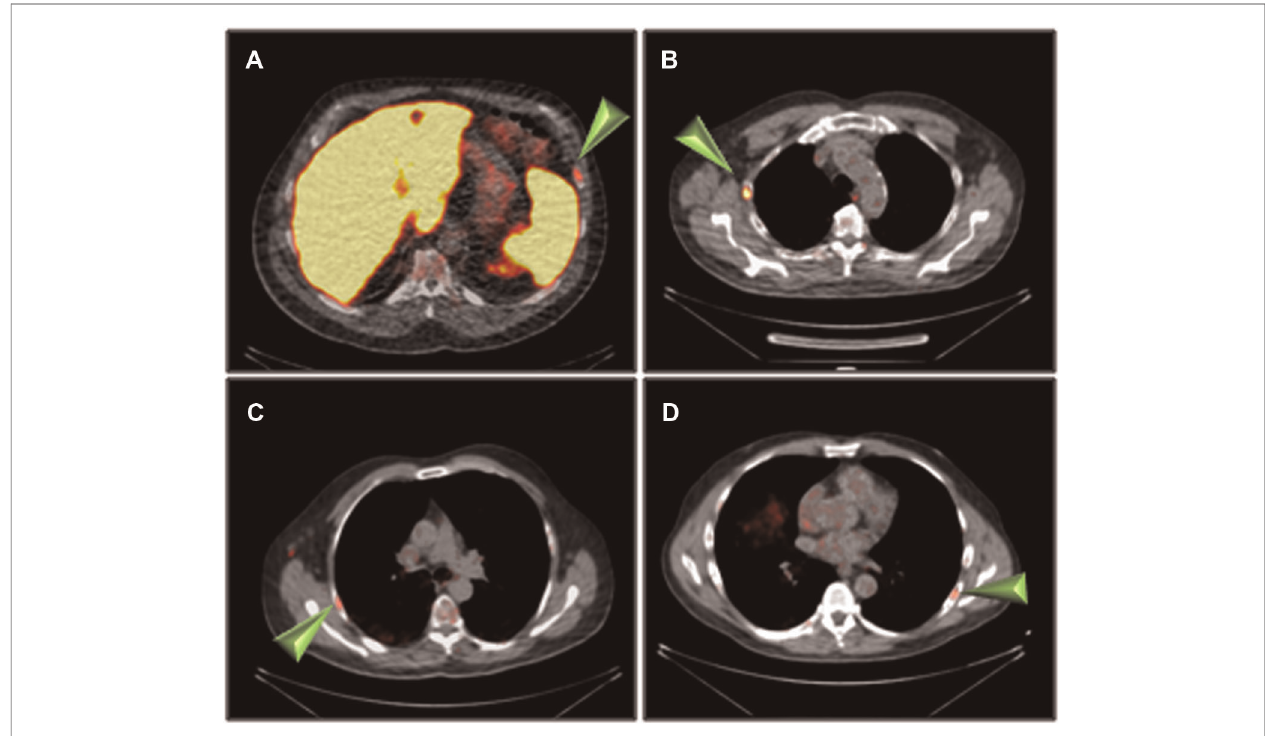
FIGURE 2 | Rib uptake of [ 18 F]PSMA-1007 (arrowheads) 2 h after injection. ( A ) patient #4, ( B ) patient #6, ( C ) patient #8, ( D ) patient #11.